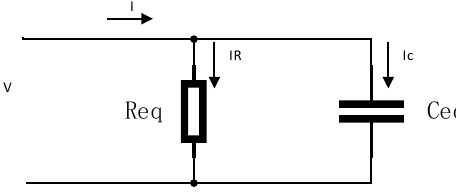
Figure 1. Parallel Equivalent circuit of a dielectric material.